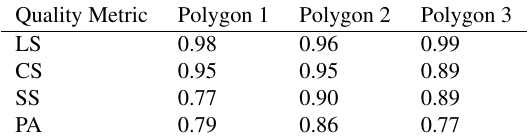
Table 1. Calculated quality measures for each polygon calculated using Concave Hull approach (Scenario